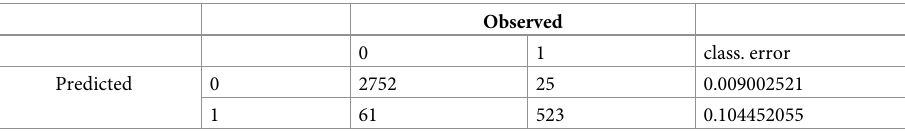
Table 6. RF confusion matrix–Model